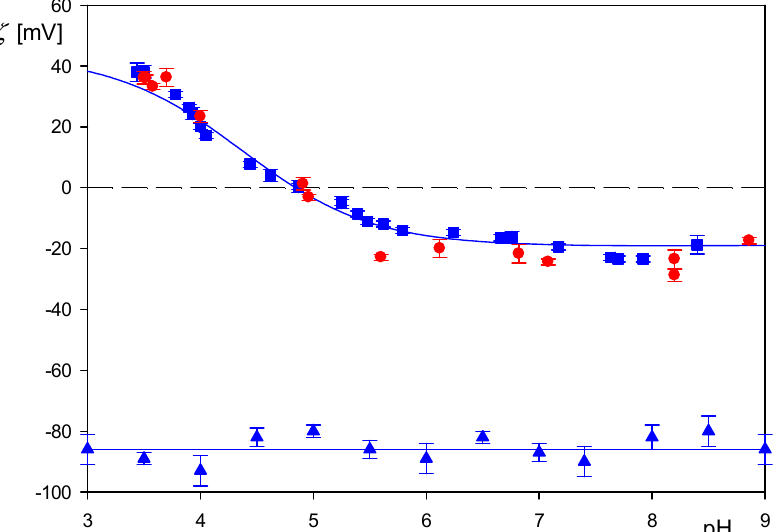
Figure 7. Dependence of the zeta potential on pH derived from the LDV measurements for 0.01 M, NaCl: ■ , myoglobin molecules in the bulk, ● , the myoglobin/particle corona (the coverage of 0.87 mg m − 2 ) transformed using Equation (7), ▲ , bare polymer particles in the bulk. The lines are fits of experimental data.